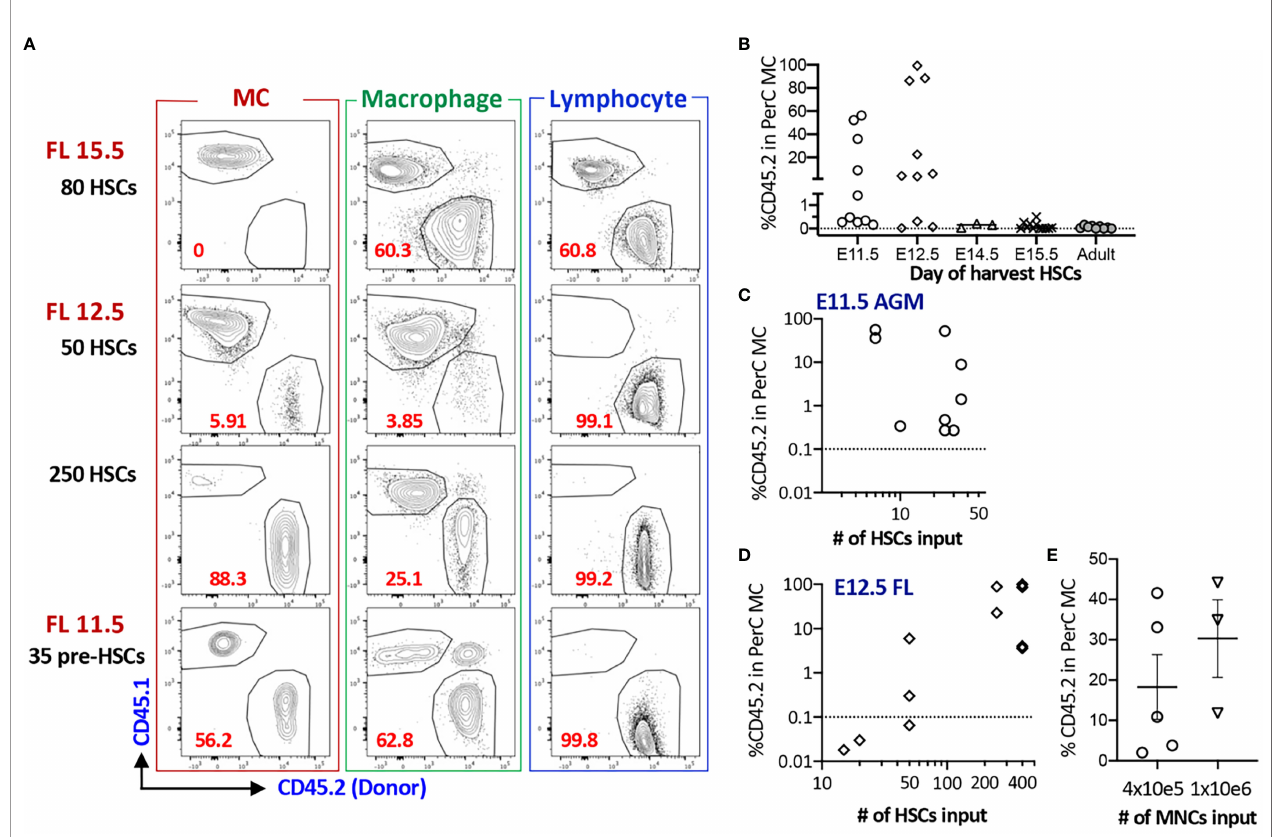
FIGURE 2 | AGM pre-HSC and FL HSC at E12.5 possess MC repopulating capacity, but not after E14.5. (A) Representative fl ow plots of MC, macrophage, and lymphoid reconstitutions from 15.5 FL, 12.5 FL HSC or E11.5 AGM pre-HSCs in PerC (gating strategy provided in S1B). (B) % Donor (CD45.2) contributions of MCs in PerC based on donor ages. (n=32 for 11.5, n=27 for E12.5, n=4 for E14.5, n=11 for E15.5, n=9 for adult BM). (C, D) Numbers of HSC transplanted and % donor (CD45.2) in the total host PerC MCs are shown for E11.5 AGM pre-HSCs (C) and E12.5 FL HSCs (D) , (E) Repopulation of MCs in PerC of NSG recipients transplanted with E14.5 FL donor MNCs are shown (n=5 and 3 in independent experiment